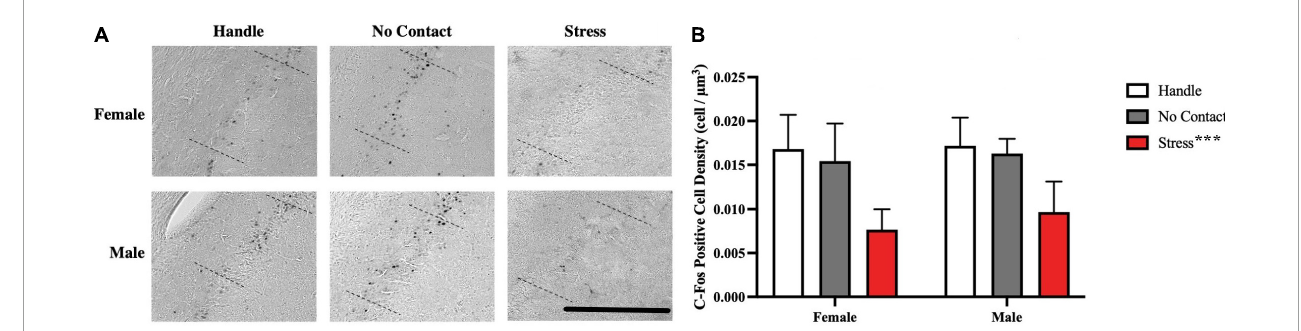
FIGURE8 Preadolescent exposure to a male is associated with reduced c-Fos positive cell density in the CA2 region. (A) Sample of c-Fos positive cells observed across groups. (B) c-Fos positive cell density within the dorsal CA2 across conditions (M + SEM). Both male and female groups exposed to the unfamiliar